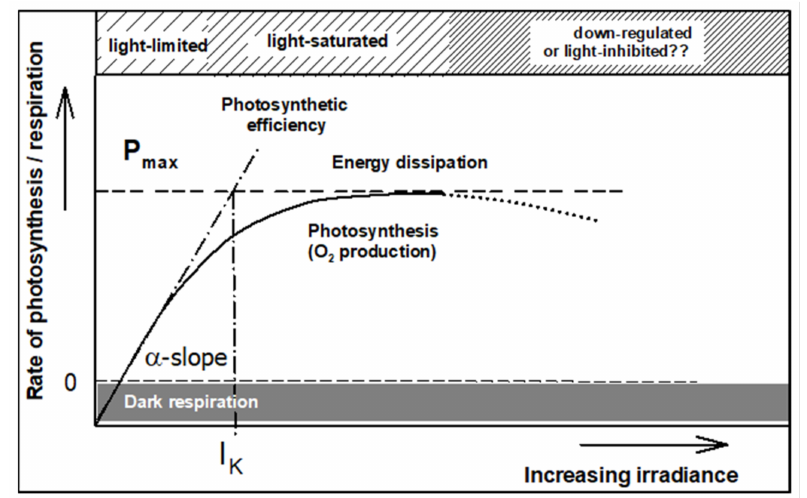
Figure 4. An illustration of a photosynthetic light-response curve, i.e., the dependency of the rate of photosynthesis on irradiance. The α -slope shows the maximum efficiency of photosynthesis (PE). The intersect between the α -slope and maximum rate of photosynthesis P max indicates the light saturation (I K ); surplus light energy over saturation is dissipated. At supra-optimum irradiance, the photosynthetic rate declines (dotted part of the light-response curve); this phenomenon is usually called down-regulation or photoinhibition (modified from Masoj í dek et al.